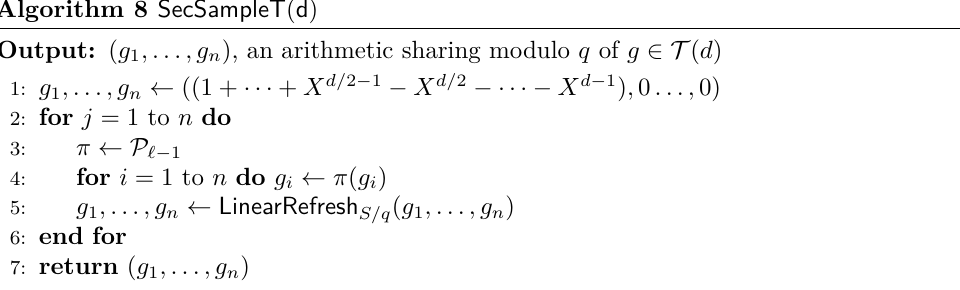
Algorithm 8 SecSampleT ( d